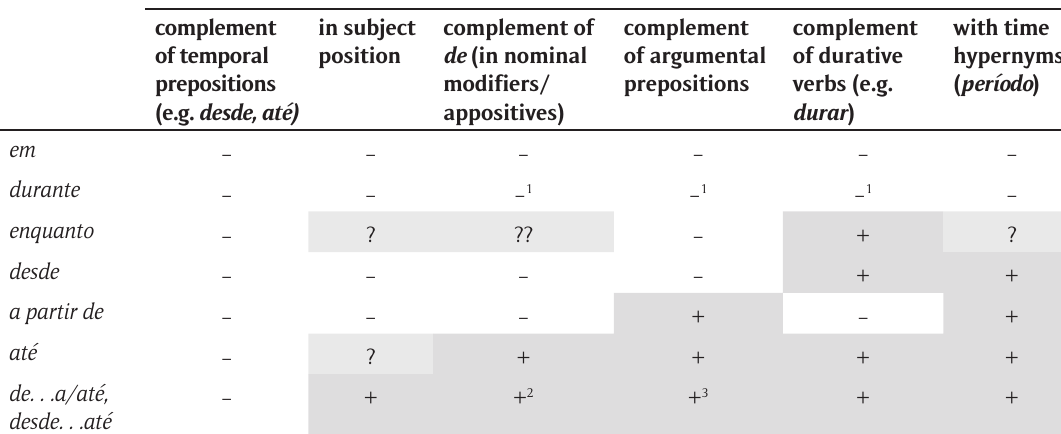
Table 2: Use of temporal locating connectives in nominal or nominal-like contexts (possibly as heads of complex time-denoting expressions). (1) a few anomalous cases found in